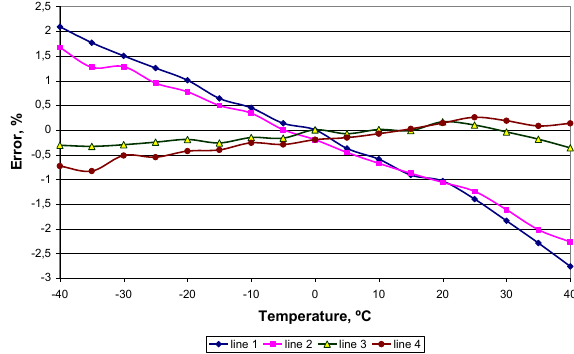
Fig. 6. Temperature error of LPG mass measurement for measuring system with RF sensor tuned for